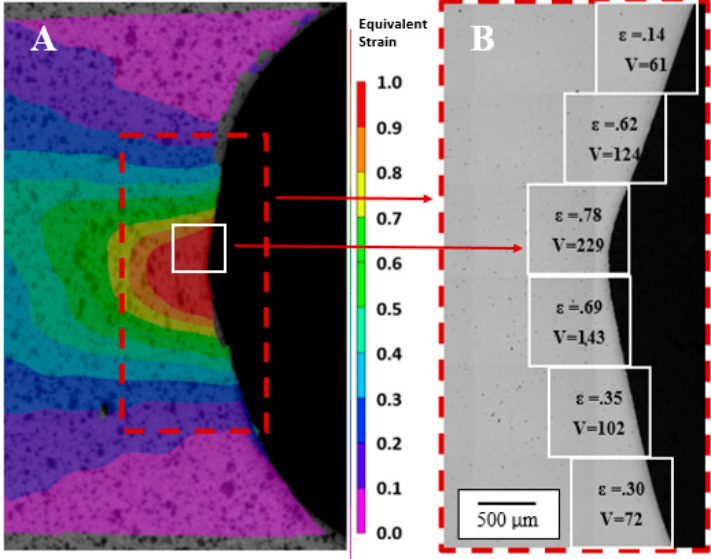
Figure 6. Contour plot of the equivalent strain and in-plane optical image of the CP800 reamed edge divided into six different strain levels along the corresponding optical image ( A ); Equivalent strain and number of voids ( V ) within each AOI are indicated ( B ).